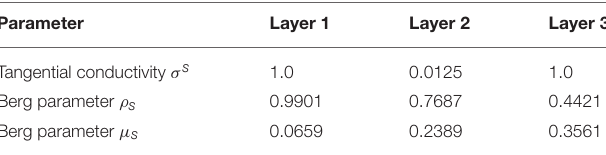
TABLE 2 | Values of the Berg parameters for the three layers [ 60,